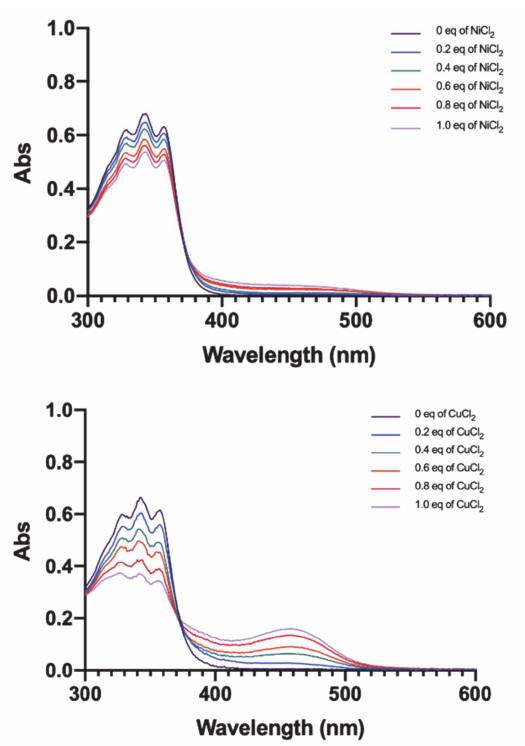
Figure 4. UV–vis titrations of L’ with nickel(II) chloride (top) and copper(II) chloride